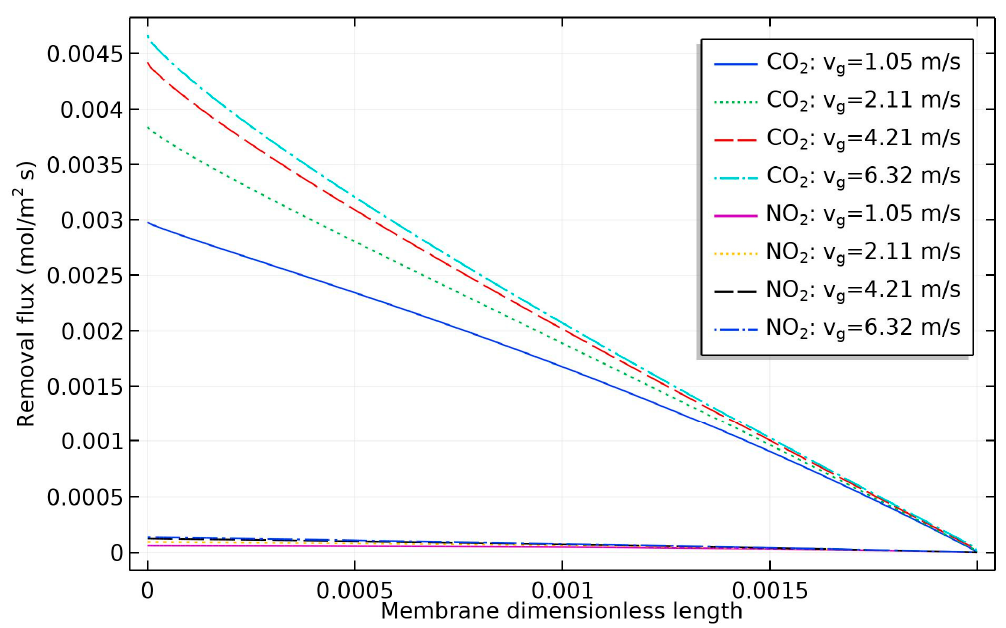
Figure 5. Effect of the variable gas velocities on the NO 2 and CO 2 removal flux along the membrane length with fixed other parameters (concentration of NaOH: 0.5 M; velocity of solvent: 0.05 m/s; gas composition: 2% CO 2 ; 300 ppm NO 2 ; the balance is N 2 ).